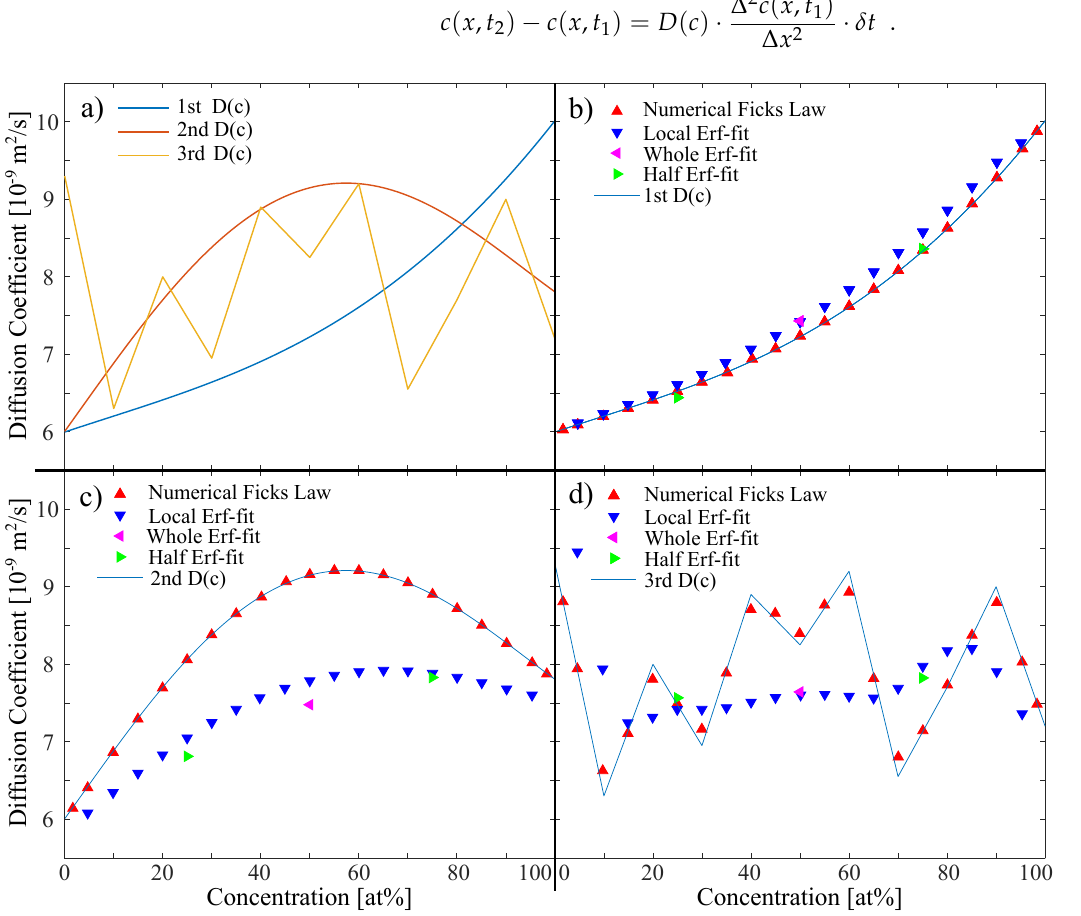
Figure 1. ( a ) Three concentration dependent diffusion coefficients D ( c ) used as input for the simulation of the concentration profiles: 1st steadily increasing, 2nd with a local maximum, and 3rd completely random distribution. The order of magnitude was chosen to match other binary melts. ( b – d ) Comparison of results for the analysis of the noise-free simulated data-sets. Local Erf-fit and Numerical Fick’s Law Approach are run on ∆ x = 5 px and ∆ t = 5